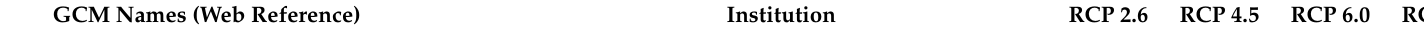
Table 2. GCM-RCP combinations for which at least one set of historical and future realizations were available in the CMIP5 multi-model ensemble. Note that for some cases; more than one realizations were available, and all of them are included for assessment in this study. S.